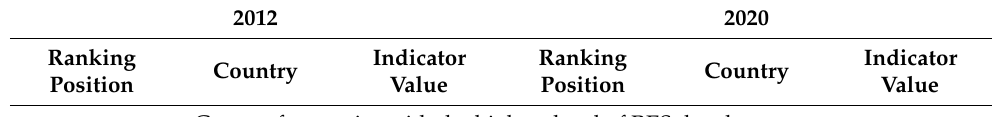
Table 2. Synthetic indicator of the RES development level of EU countries in 2012 and 2020 based on Hellwig’s taxonomic measure of